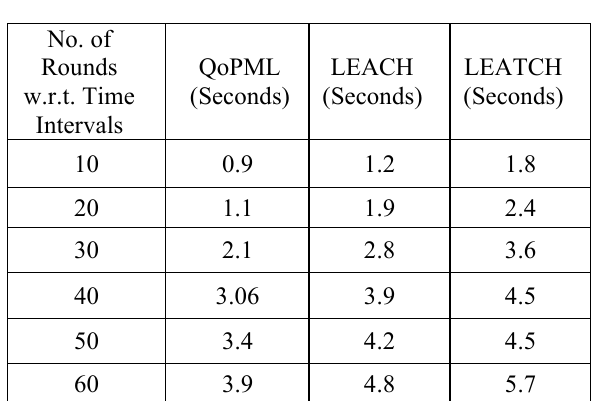
Table 3. Time efficiency with respect to node